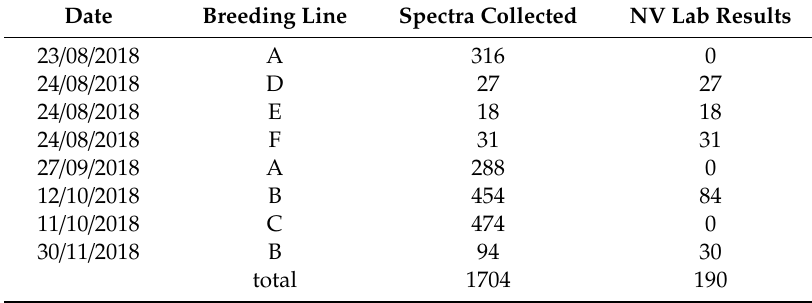
Table 1. The dates, breeding line and number of canopy spectra collection and vegetation harvested for lab analysis.